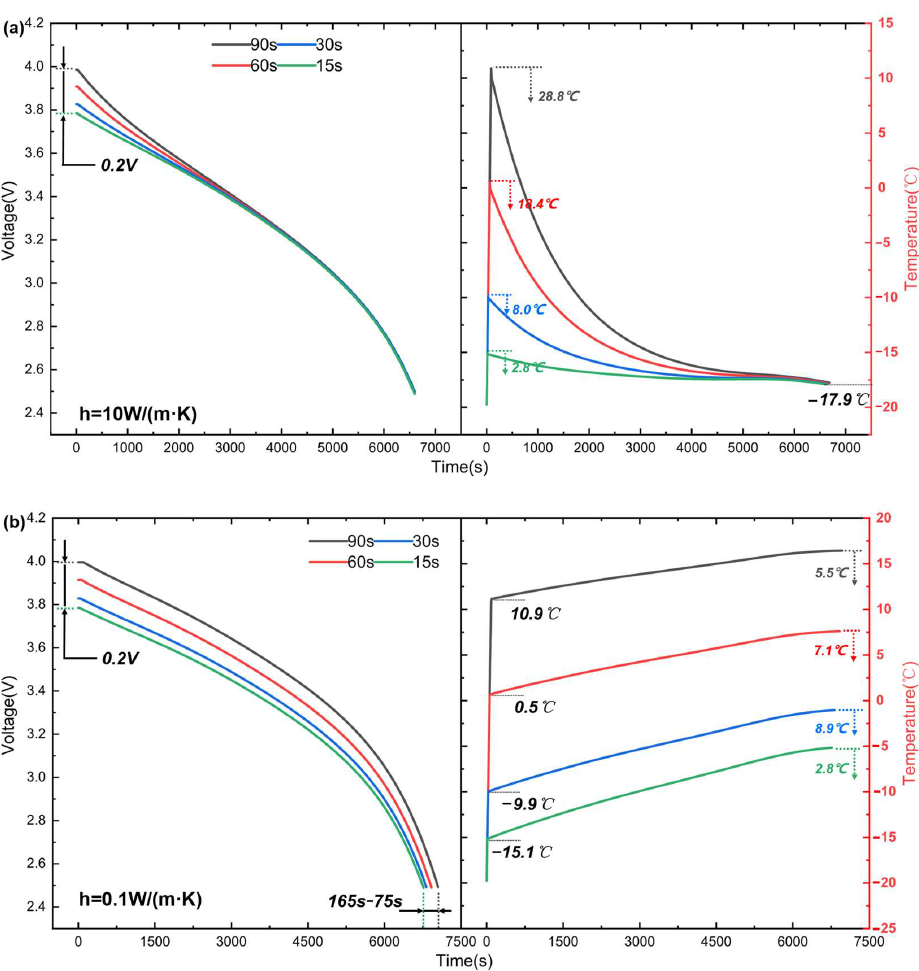
Figure 3. Voltage ( left ) and temperature curve ( right ) of 0.5C discharge at different heating times: ( a ) Without insulation; ( b ) With insulation conditions.